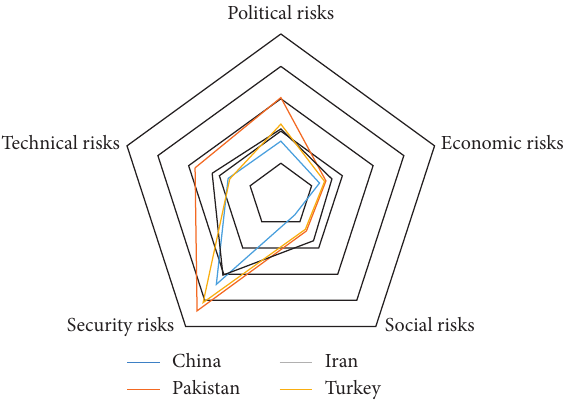
Figure 10: The suboperational risks of CPITC